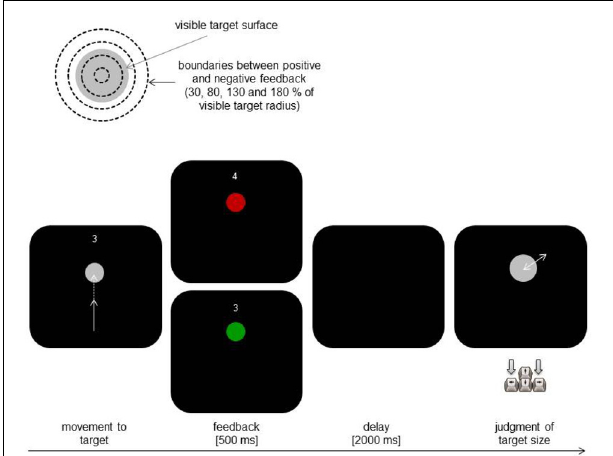
FIGURE 5 | Schematic illustration of the critical manipulation (upper part) and of the main trial events in Experiment 3 (lower part).